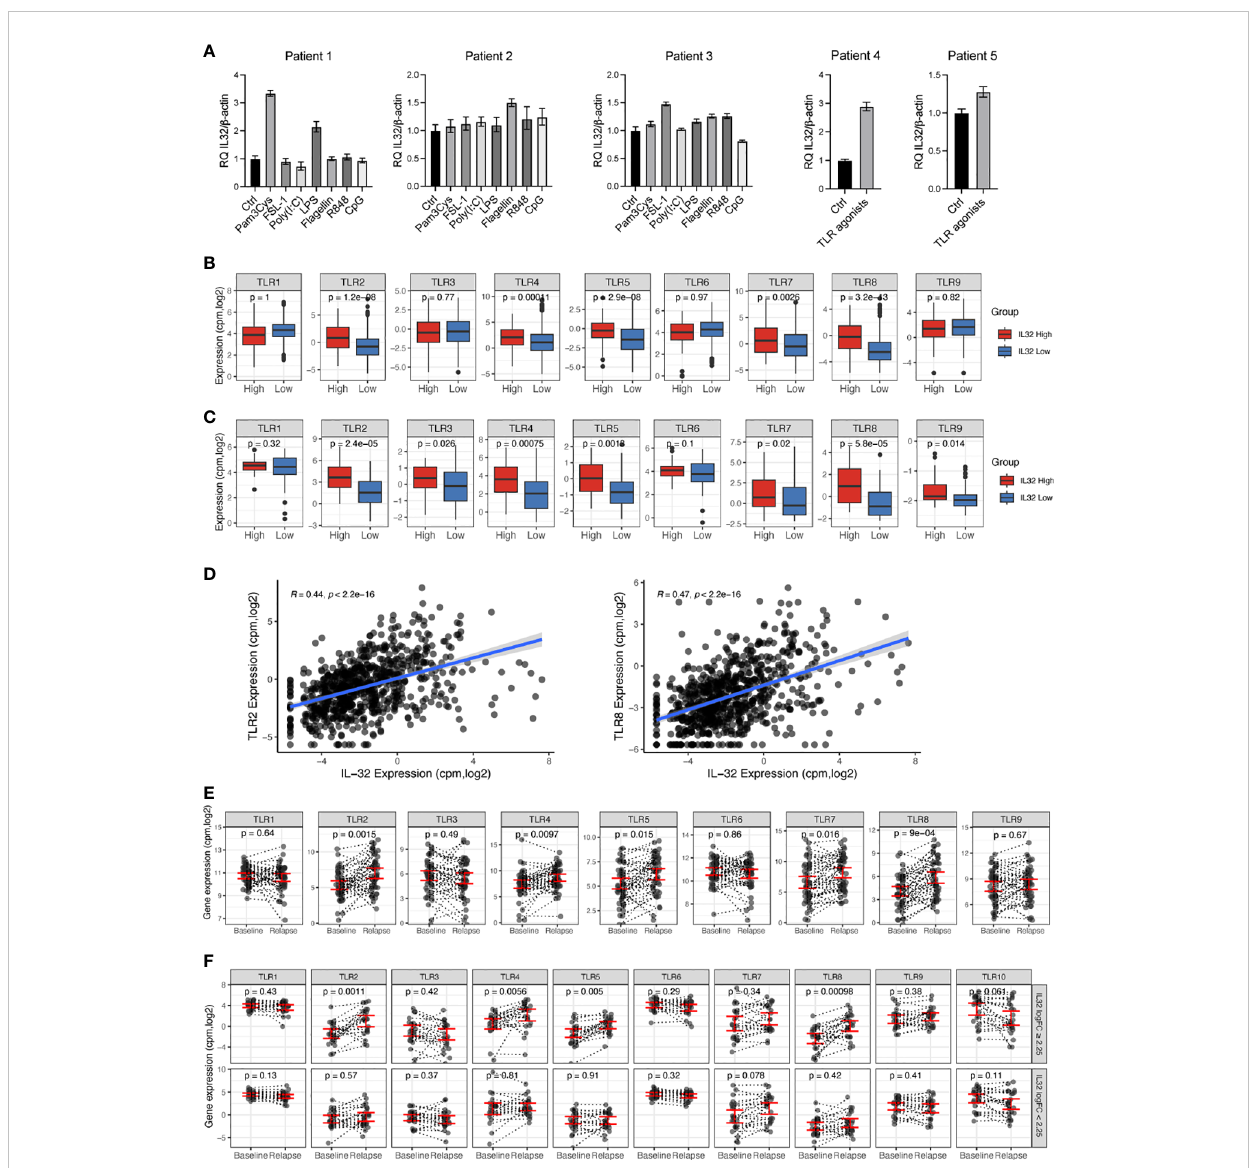
FIGURE 2 IL-32 is associated with TLR expression in primary MM cells. (A) Freshly obtained primary CD138+ myeloma cells were stimulated with TLR agonists for 4 hours and IL-32 expression was evaluated by qPCR. The fi gure shows mean RQ ± SD of technical replicates. The Ct-values for IL-32 in untreated cells were for patient #1: 33.13, patient #2: 34.05, patient #3: 31.32, patient # 4: 31.92 and patient #5: 32.43. (B) TLR gene expression in IL-32 expressing patients (upper10 th percentile) compared to non-expressing patients (lower 90 th percentile) in CoMMpass IA13. (C) TLR gene expression in IL-32 expressing patients (upper 30 th percentile) compared to non-expressing patients (lower 70 th percentile) in our own (Biobank1) dataset. (D) Plot showing Pearson correlation between IL-32 and TLR2 and TLR8 in the CoMMpass IA13 dataset. (E) TLR expression at diagnosis and fi rst relapse timepoint in RNA-sequenced longitudinal CD138+ patient samples from CoMMpass IA13. Figure shows the mean ± SEM for TLR expression at diagnosis and relapse. (F) TLR expression between diagnosis (baseline) and relapse for patients with an FC ≥ 2.25 increase of IL-32